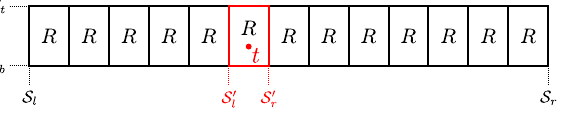
Figure 5: The Repeat operator applies a subdivision into elements of the same size. This enables us to directly calculate the scope which is hit by the texture coordinates t .